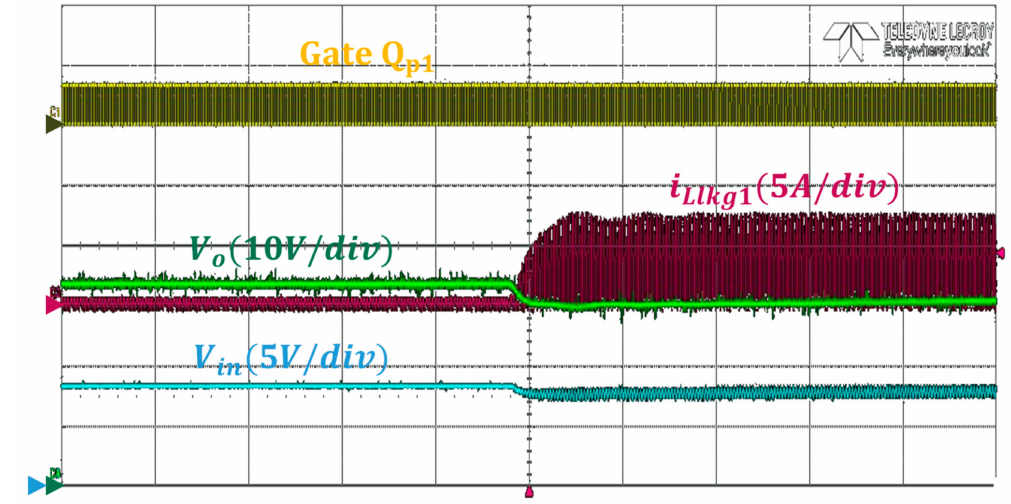
Figure 16. Experimental key waveform of the DPP converter at the load transition.